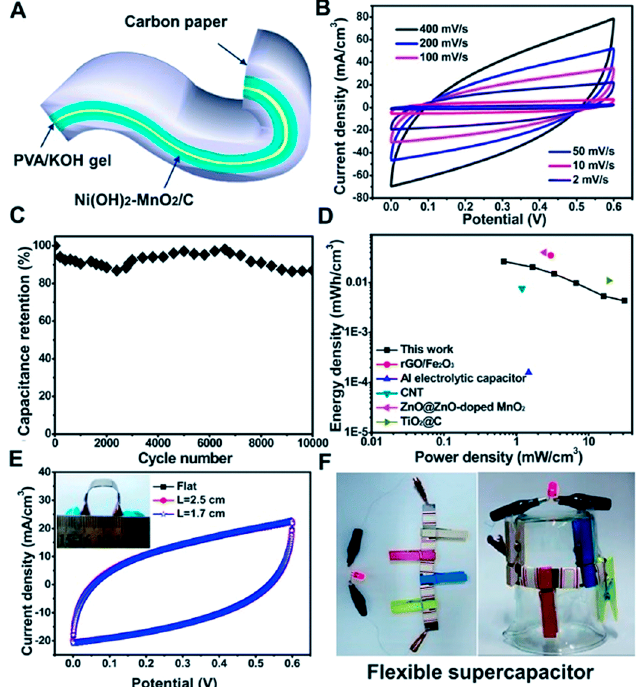
Figure 12. Electrochemical investigation of Ni (OH) 2 –MnO 2 /C composite-based flexible all-solid-phase supercapacitor cell. ( A ) Picture for the configuration of the assembled cell. ( B ) CV curves at various scan rates. ( C ) Cyclic performance at 11.2 mA cm − 3 . ( D ) Ragone plots. ( E ) CV curves at various bending conditions. Inset: photo for a bent cell. ( F ) Photos for a red LED brightened by tandem cells under the flat (left) and the bending condition (right) [173].